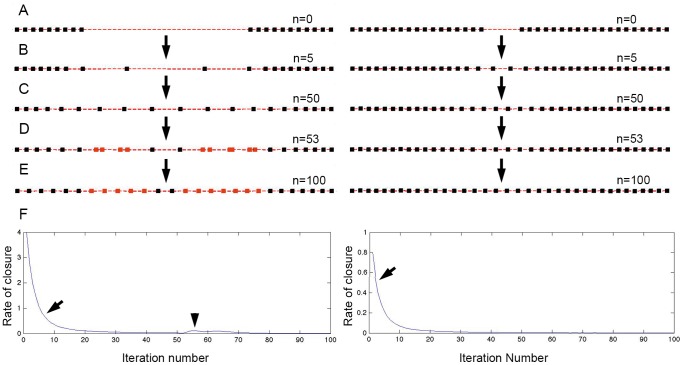
Modeling cell migration and cell proliferation during kidney repair.(A) Initial arrangement of cells in the simulation. Each square represents a single cell position. Our model is based on that published in19, with an addition of a ‘free edge’. (B, C) After 5 and 50 iterations of the algorithm, cells have migrated to mostly recover the epithelial gap. In the illustrated simulation, we introduced a delay in cell proliferative response to stretch. Simulations produce very similar results with or without delay (Movie S8 and S9), but presence of a delay is more reflective of the experimental observations. (D, E, left, gray markers) show divided cells in response to cell stretch after ‘long segment ablation’. (A–E, right) demonstrate that after ‘short ablation’ no cell proliferation is induced. (F) Plots of the ‘rate of migration’ after long (left panel) vs. short (right panel) segment ablation. Arrows point to a rapid decrease of the rate of migration due to cell-cell interaction. This was similar to the experimentally observed migration rate decline (Figure 2). A second small peak in migration (arrowhead) is due to cell division.